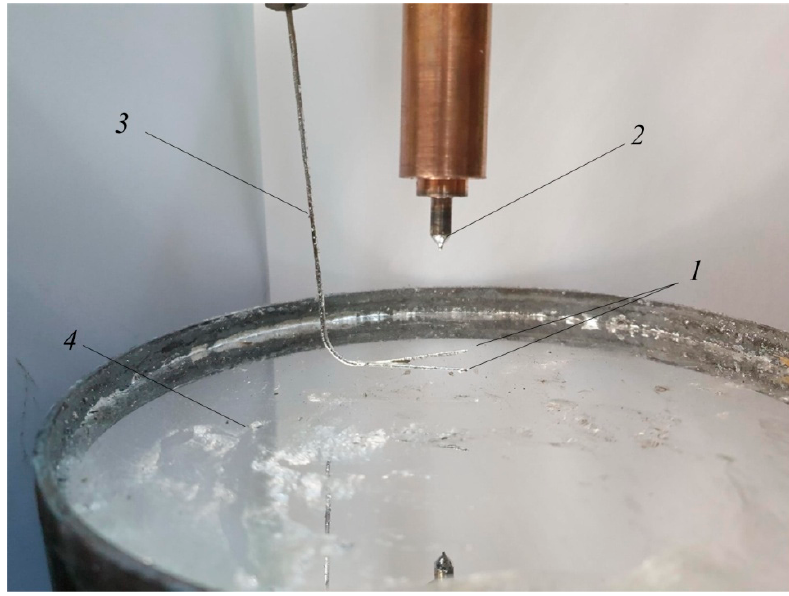
Figure 7. Photo of the thermocorrelation probe over the surface of the liquid metal. 1 —thermocouples; 2 —small electrode with a drop of liquid metal; 3 —probe holder; and 4 —In-Ga-Sn.